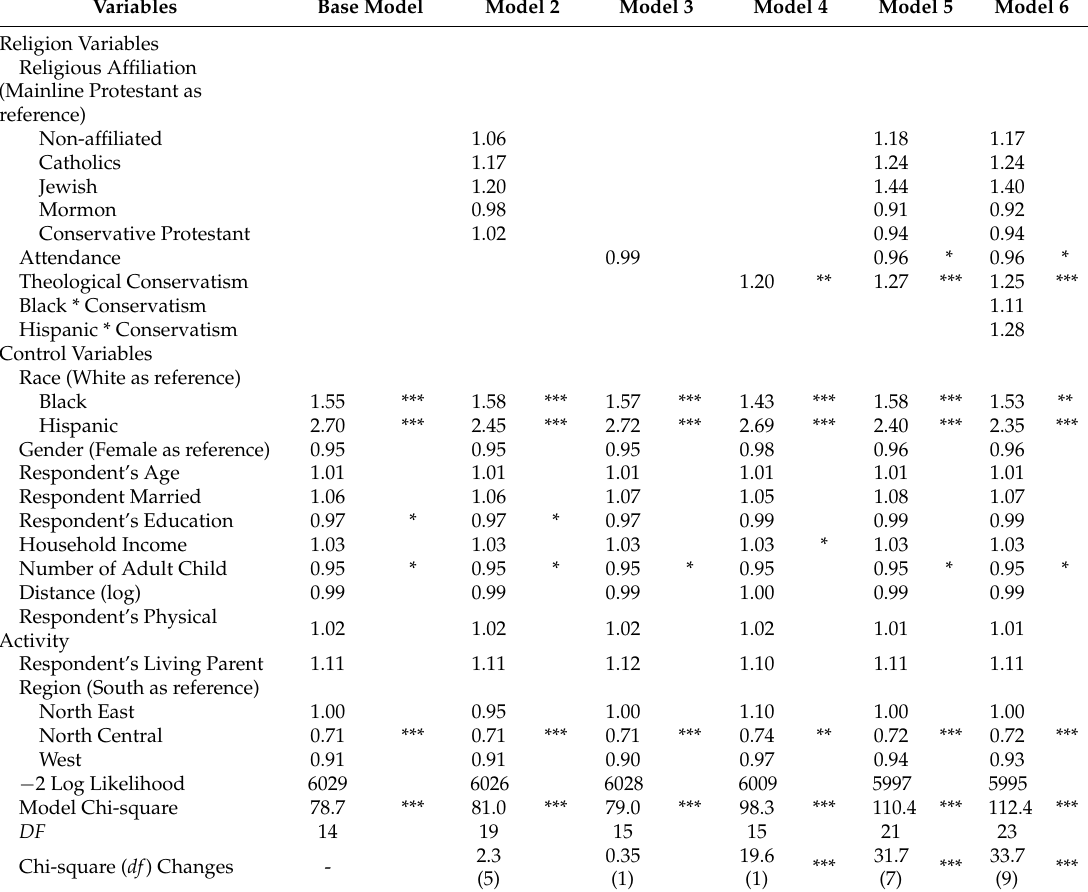
Table 3. Odds Coefficients of Ordered Logistic Regressions to Predict Parents Ought to Provide Residence ( n =